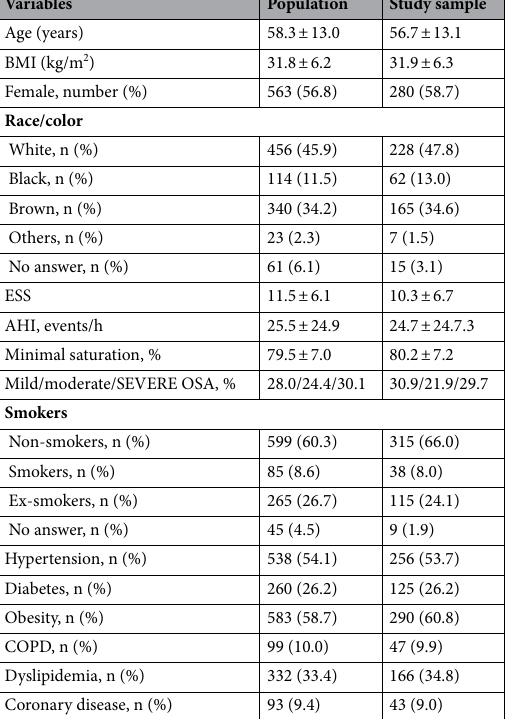
Table 1. Descriptive characteristics of the patients in the task force and study sample. BMI body mass index, COPD chronic obstructive pulmonary disease, ESS epworth sleepiness scale, AHI apnea–hypopnea index.